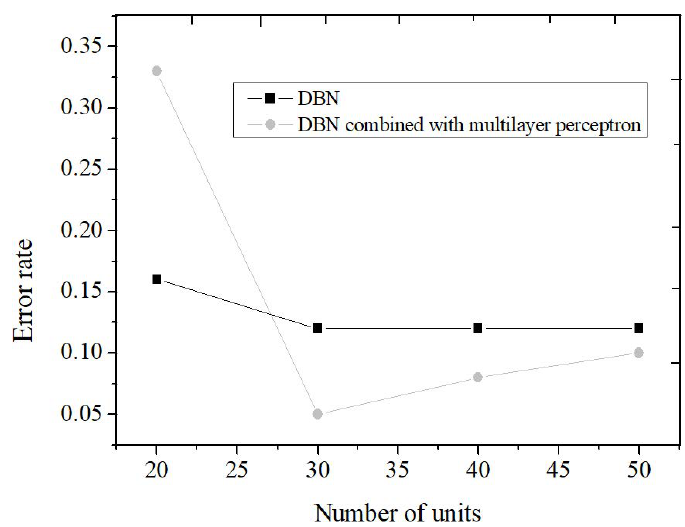
Fig. 6 Relationship between model error rate and number of units. DBN: deep belief network